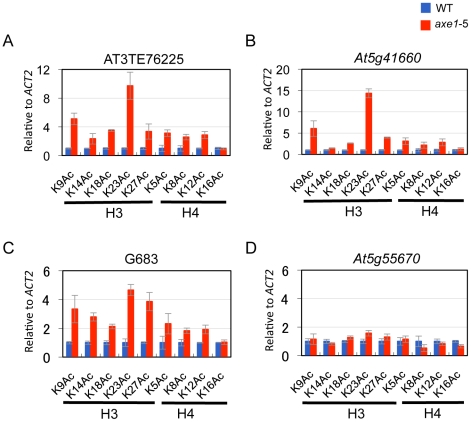
Elevated acetylation at all H3 and H4 lysines except H4K16 in
axe1-5.ChIP-qPCR assays for all of the potential deacetylation substrates of
histone H3 and H4 N-tails (acetylation sites, K9, K14, K18, K23, K27 of
H3 and K5, K8, K12, K16 of H4) were examined on (A) AT3TE76225, (B)
At5g41660, (C) G683 and a negative
control gene (D) At5g55670. Specific antibodies against
each acetylated lysine were used (See Materials and Methods for detail). The normalized
acetylation enrichments in axe1-5, relative to those in
the wild-type plant are shown as the mean plus standard deviation
obtained from three independent immunoprecipitated DNA experiments
(blue, WT; red, axe1-5).